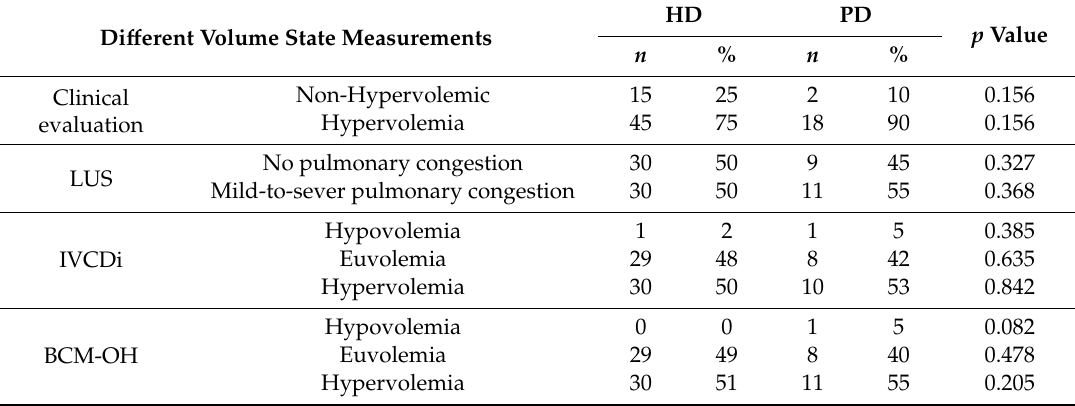
Table 8. Comparison of the number of patients in di ff erent hydration states. Di ff erent Volume State Measurements